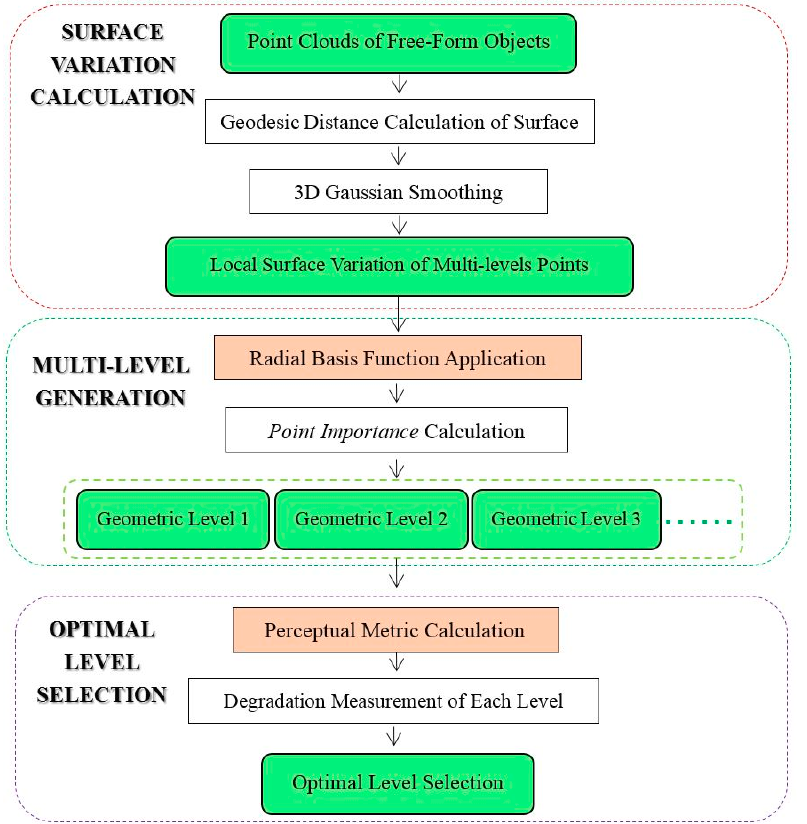
Figure 2. Working flowchart of the proposed method.